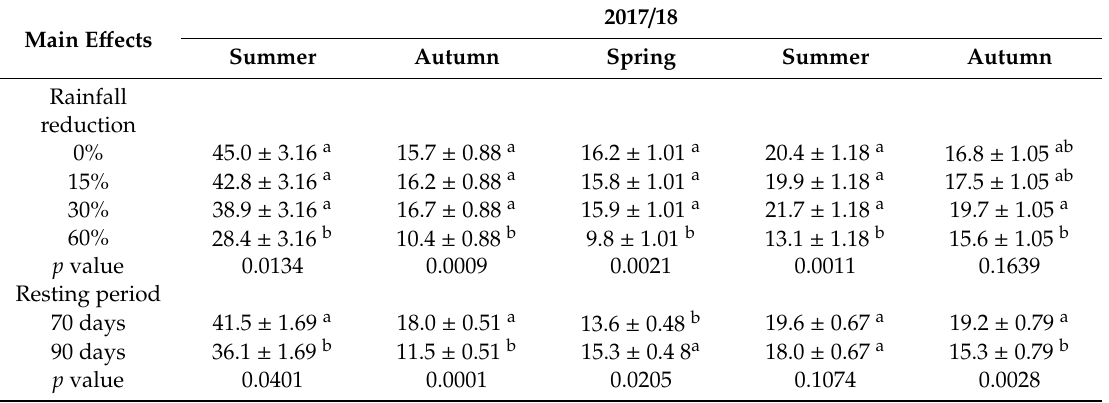
Table 3. Main e ff ect of resting period and rainfall reduction on vegetation sward (mean ± S.E) height